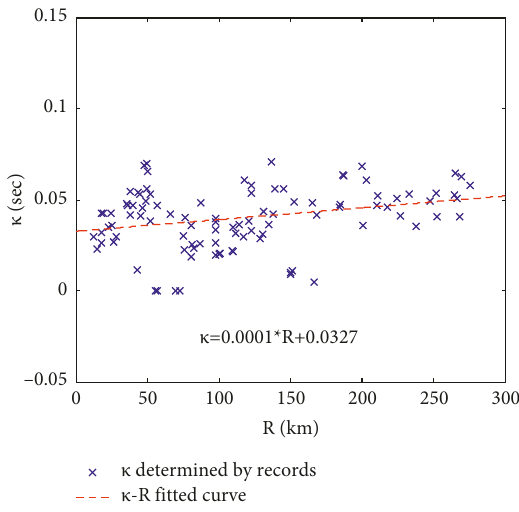
Figure 7: Dependency between κ and